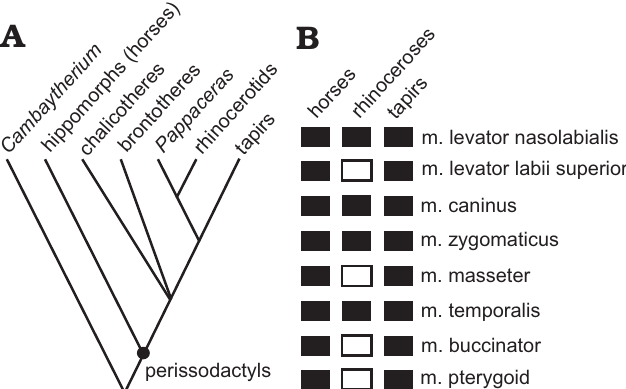
Fig. 1. Extant phylogenetic bracket (EPB) from which the cranial muscles in Pappaceras meiomenus are hypothesized. A . Simplified phylogeny of perissodactyls based on recent studies (Rose et al. 2014; Wang et al. 2016). B . Data for cranial muscles from extant perissodactyls, mainly taken from Beddard and Treves (1898), Boas and Paulli (1908), Sisson (1914), Gregory (1920), Bressou (1961), Witmer et al. (1999), Clifford (2003) and Bernardes et al. (2013). Solid rectangles denote the presence of references regarding certain muscle in extant perissodactyls, whereas open rectangles indicate a lack of